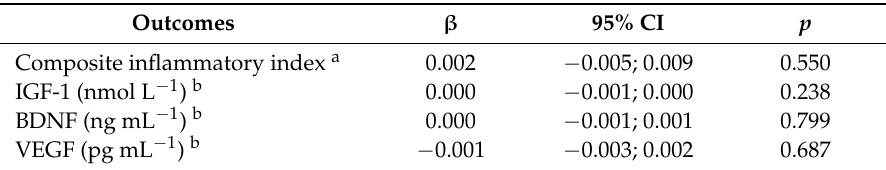
Table 3. Associations between plasma selenium concentration and the composite inflammatory index and neurotrophic markers in 154 older